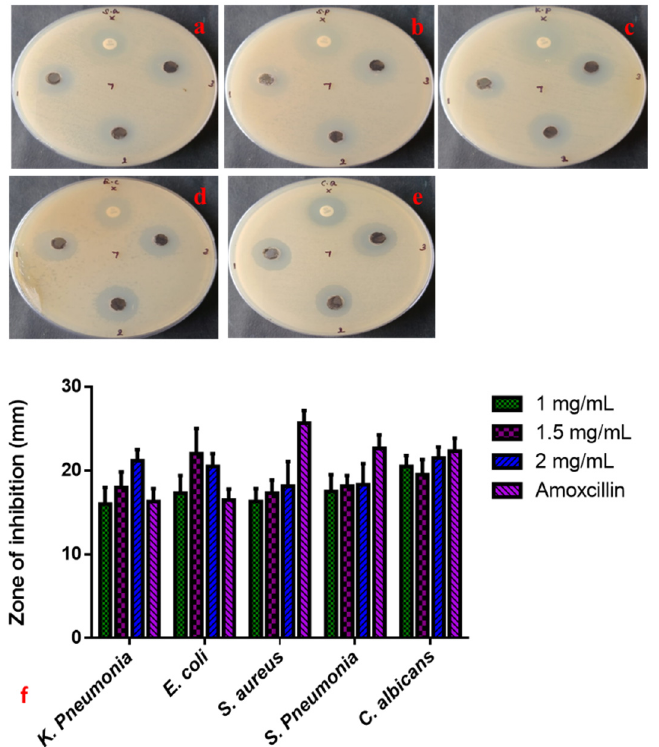
Figure 4. Anti-microbial activity of CuO-TiO 2 -chitosan-escin nanocomposites. Anti-bacterial activity ( a – e ) and zone of inhibition ( f ) of CuO-TiO 2 -chitosan-escin nanocomposites treated with S. aureus ( a ), S. pneumonia ( b ), K. pneumonia ( c ), E. coli ( d ), and C. albicans ( e ) strains.